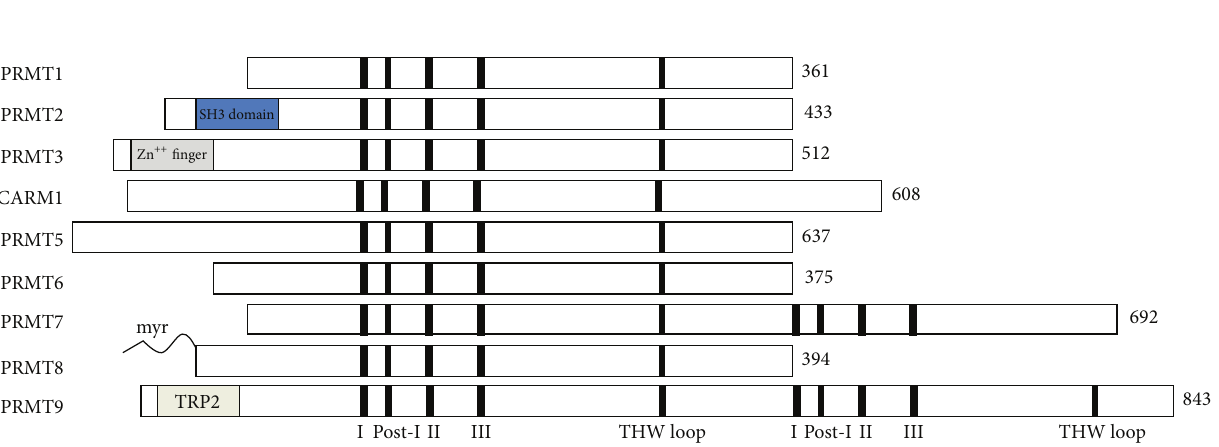
Figure 2: Structure of the PRMT